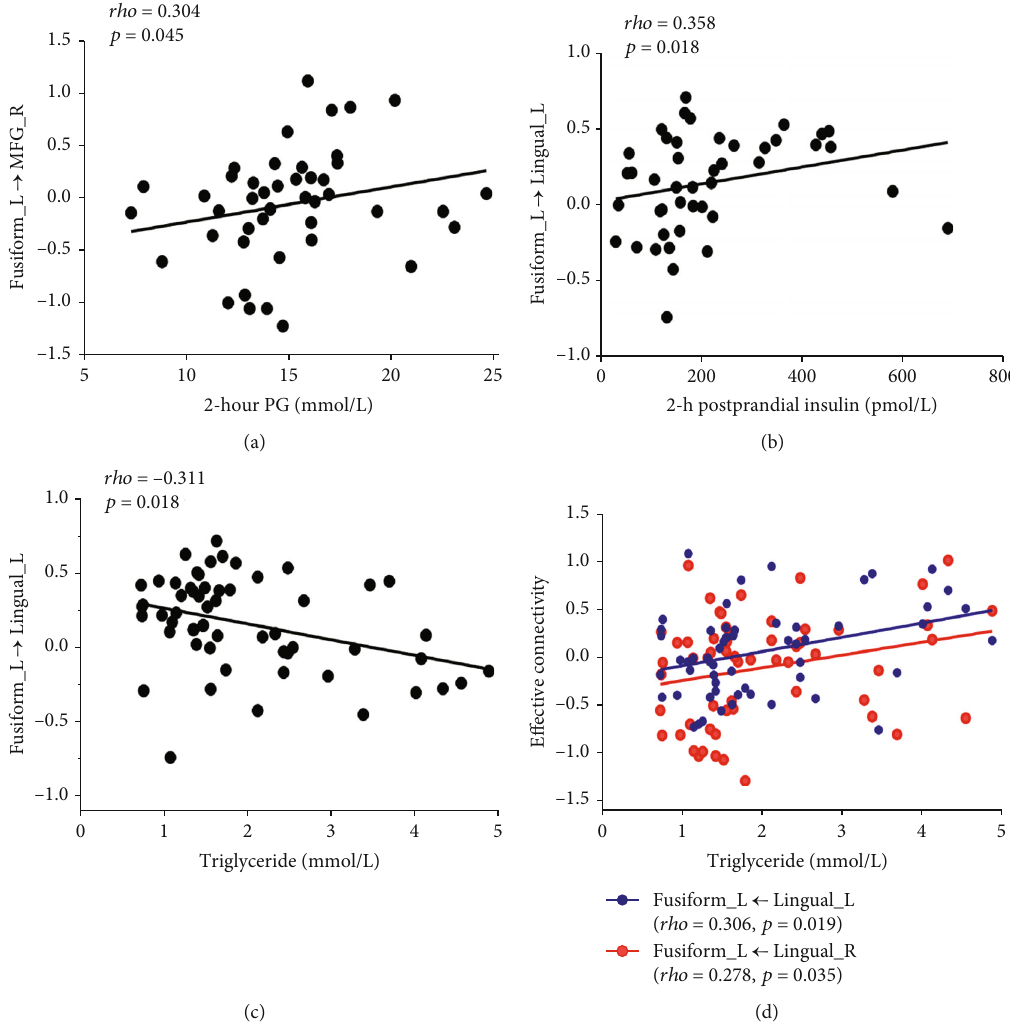
Figure 3: Signi fi cant correlations between abnormal e ff ective connectivity of left fusiform and clinical characteristics in type 2 diabetes ( P < 0 : 05